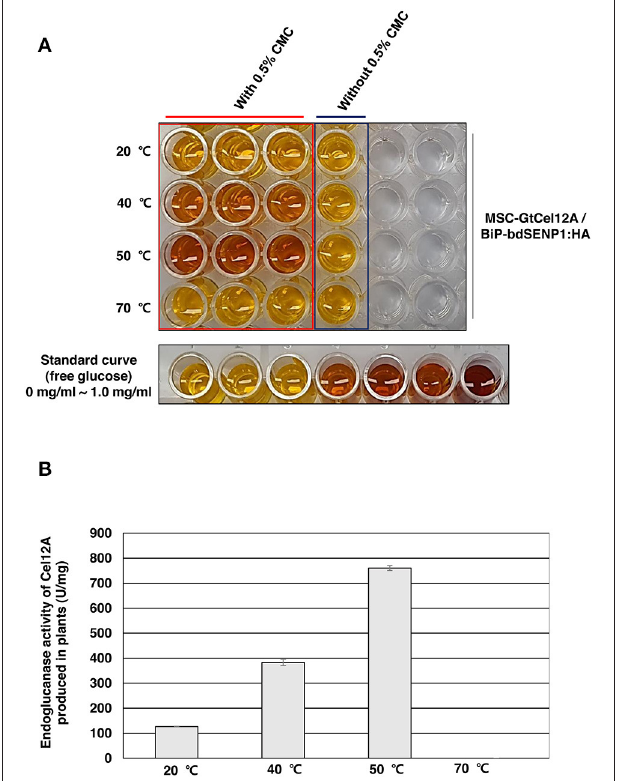
FIGURE 6 | GtCel12A-CBM3 immobilized on MCC beads exhibits efficient endoglucanase activity at 50 ◦ C . (A) Endoglucanase activity of GtCel12A-CBM3 immobilized on MCC beads was determined at indicated temperatures by measuring the reducing sugar content using dinitrosalicylic acid (DNS) assay. The enzyme reaction was performed at pH 3.0. The endoglucanase activity is shown by the change in DNS color. (B) Quantification of specific GtCel12A-CBM3 activity. One unit (U) is defined as the amount of GtCel12A-CBM3 that can release 1 µ mol of glucose from CMC per min. All the reactions were performed three times (biological replicates) and each reaction was performed in triplicate per plate (technical replicates). Data represent means ( n = 3) ± standard deviation in which n represents biological